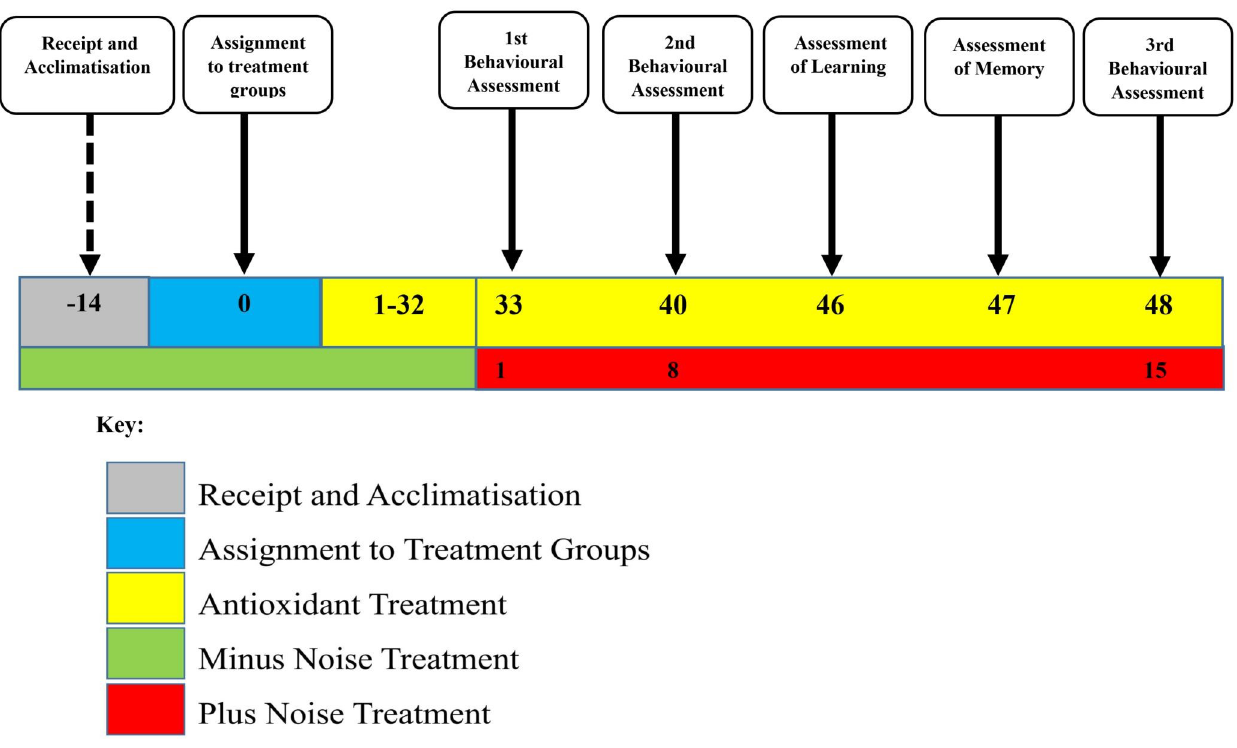
Fig 1. Experimental